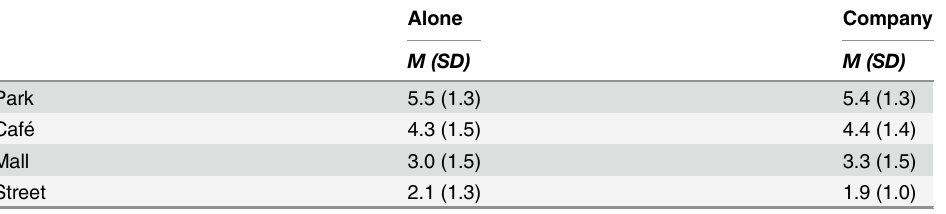
Note : Scores fall on a scale from 1 = not likely at all to 7 = very